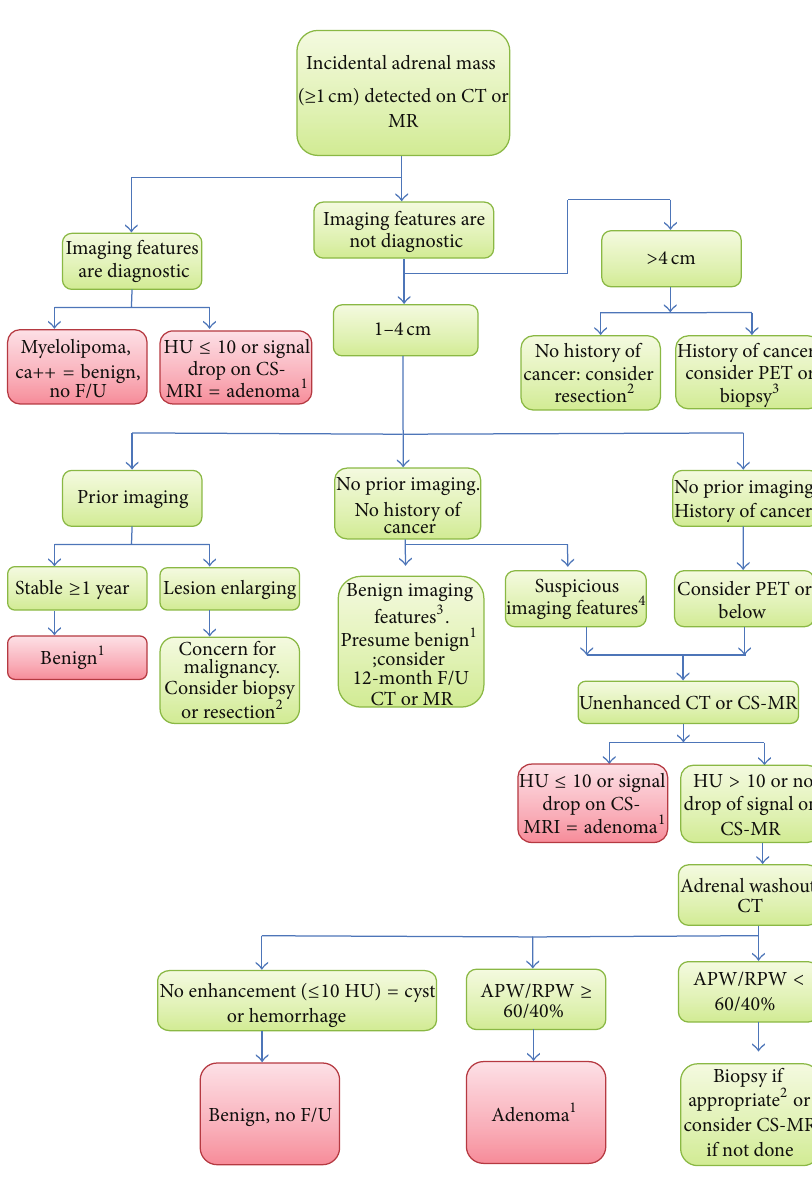
Figure 1: ACR guidelines flow chart